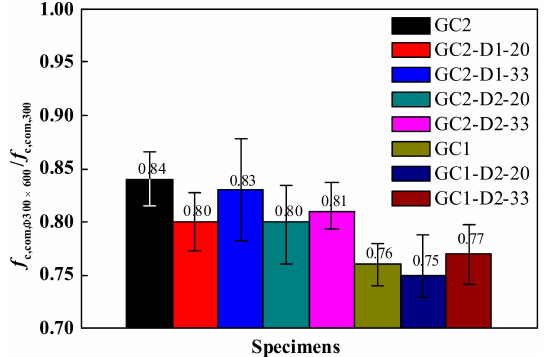
Figure 9. Ratio of compressive strength of GRLC cylindrical specimen to cubic